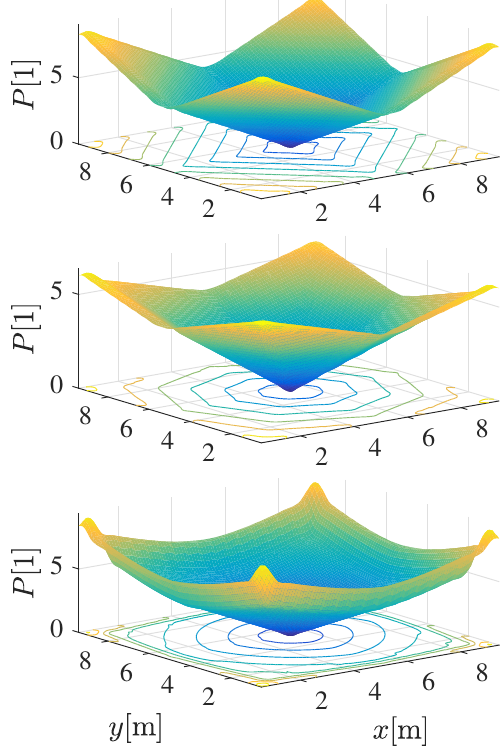
Figure 5. Interpolated potential function P ( x , y ) based on the discrete potential obtained by A ∗ with 4 and 8 neighbour cells connections and by E ∗ . The obtained gradient is in the directions of multiples of 90 ◦ or 45 ◦ when 4 or 8 neighbourhood connections are used in A ∗ . While E ∗ can have arbitrary directions, which can be seen from the contours of equal potentials orthogonal to the gradient